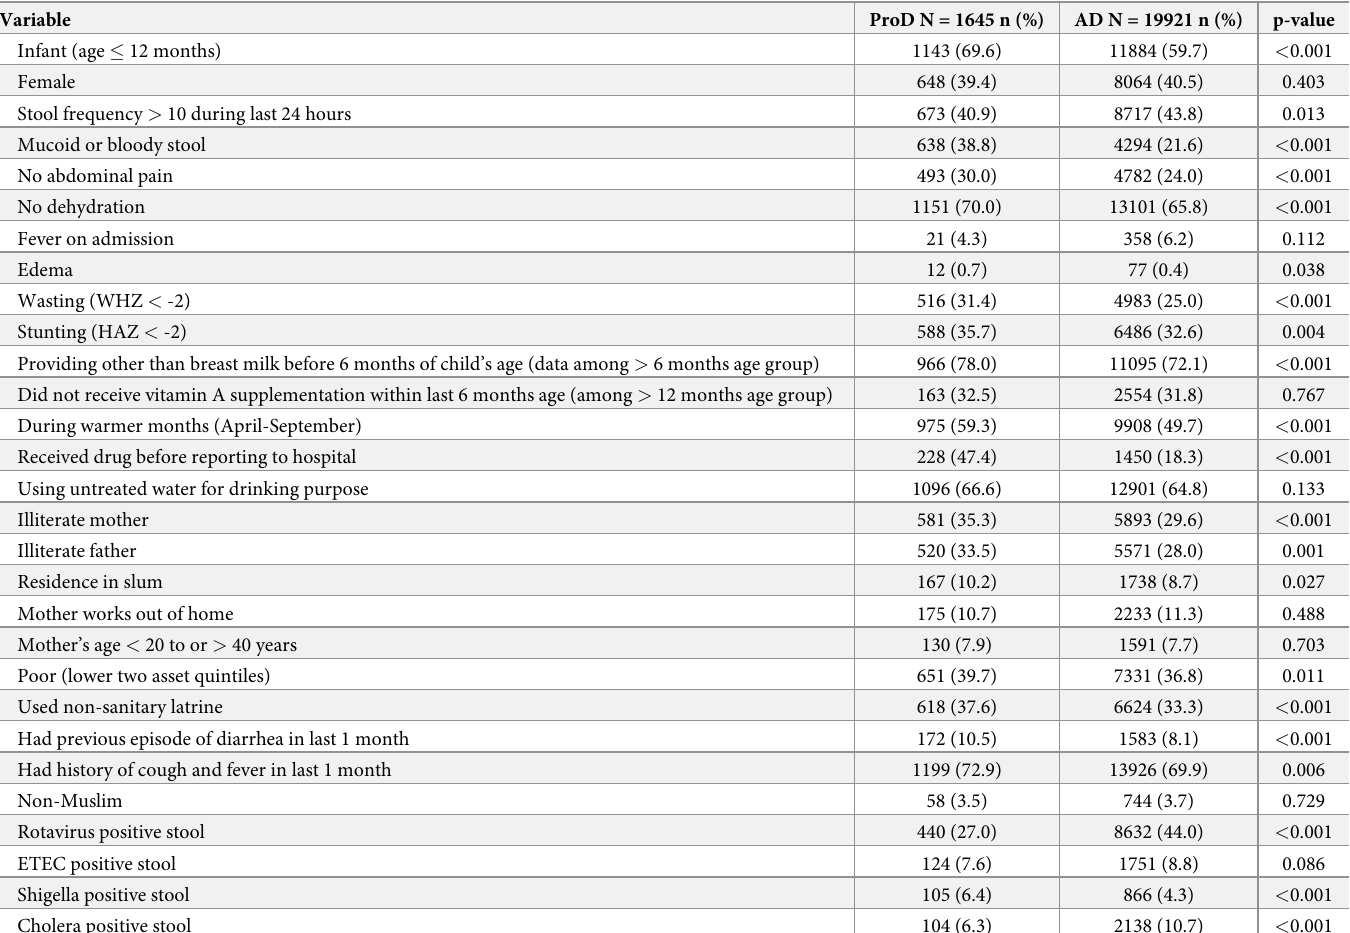
Table 1. Differential features of under-five children with prolonged diarrhea (ProD) (diarrhea for > 7 to 13 days) and acute diarrhea (AD) (diarrhea for � 7